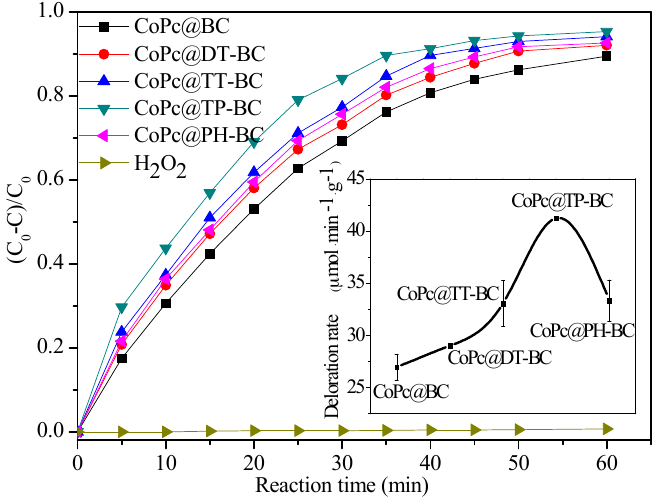
Figure 7. Catalytic oxidation of reactive red X-3B (initial concentration 100 μ M, pH = 2, T = 50 °C) with CoPc@s-BC (1 mg) and H 2 O 2 (8 mM). Inset: effect of the spacer length on the decoloration rate of reactive red X-3B.